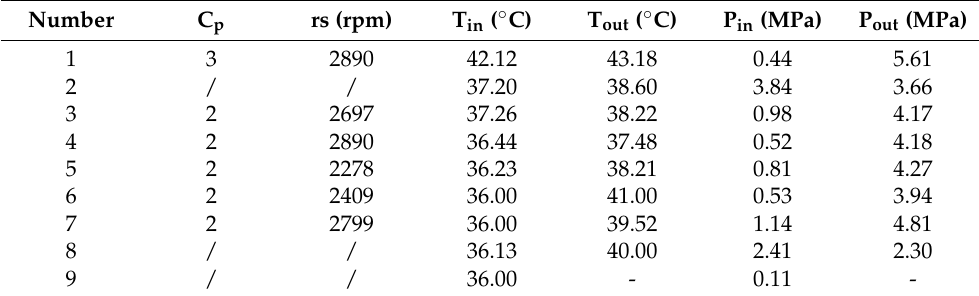
Table A3. PSO simulation operation scheme.